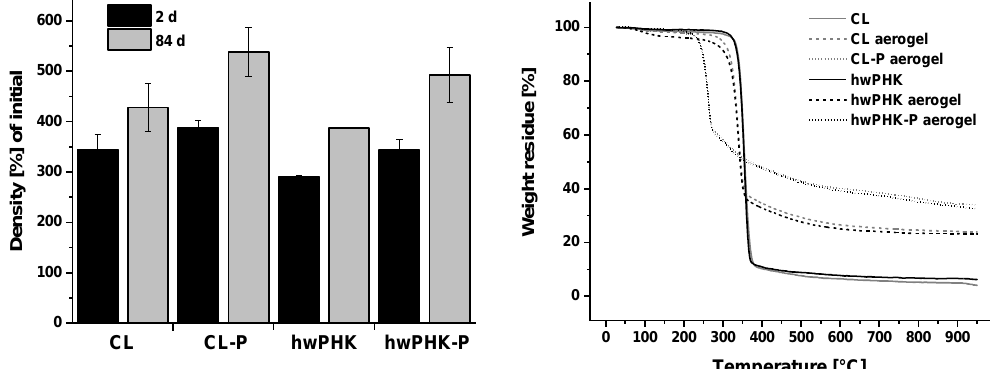
Figure 6. Bulk density [%] of phosphorylated and non-derivatized aerogels after two and 84 days during conditioning at 65% RH (left). Thermogravimetric analysis of cellulose II aerogels from non-derivatized and slightly phosphorylated cotton linters (CL, CL-P) and hardwood prehydrolysis kraft pulp (hwPHK, hwPHK-P). TGA profiles of the unprocessed source materials were recorded for reference purposes (right).